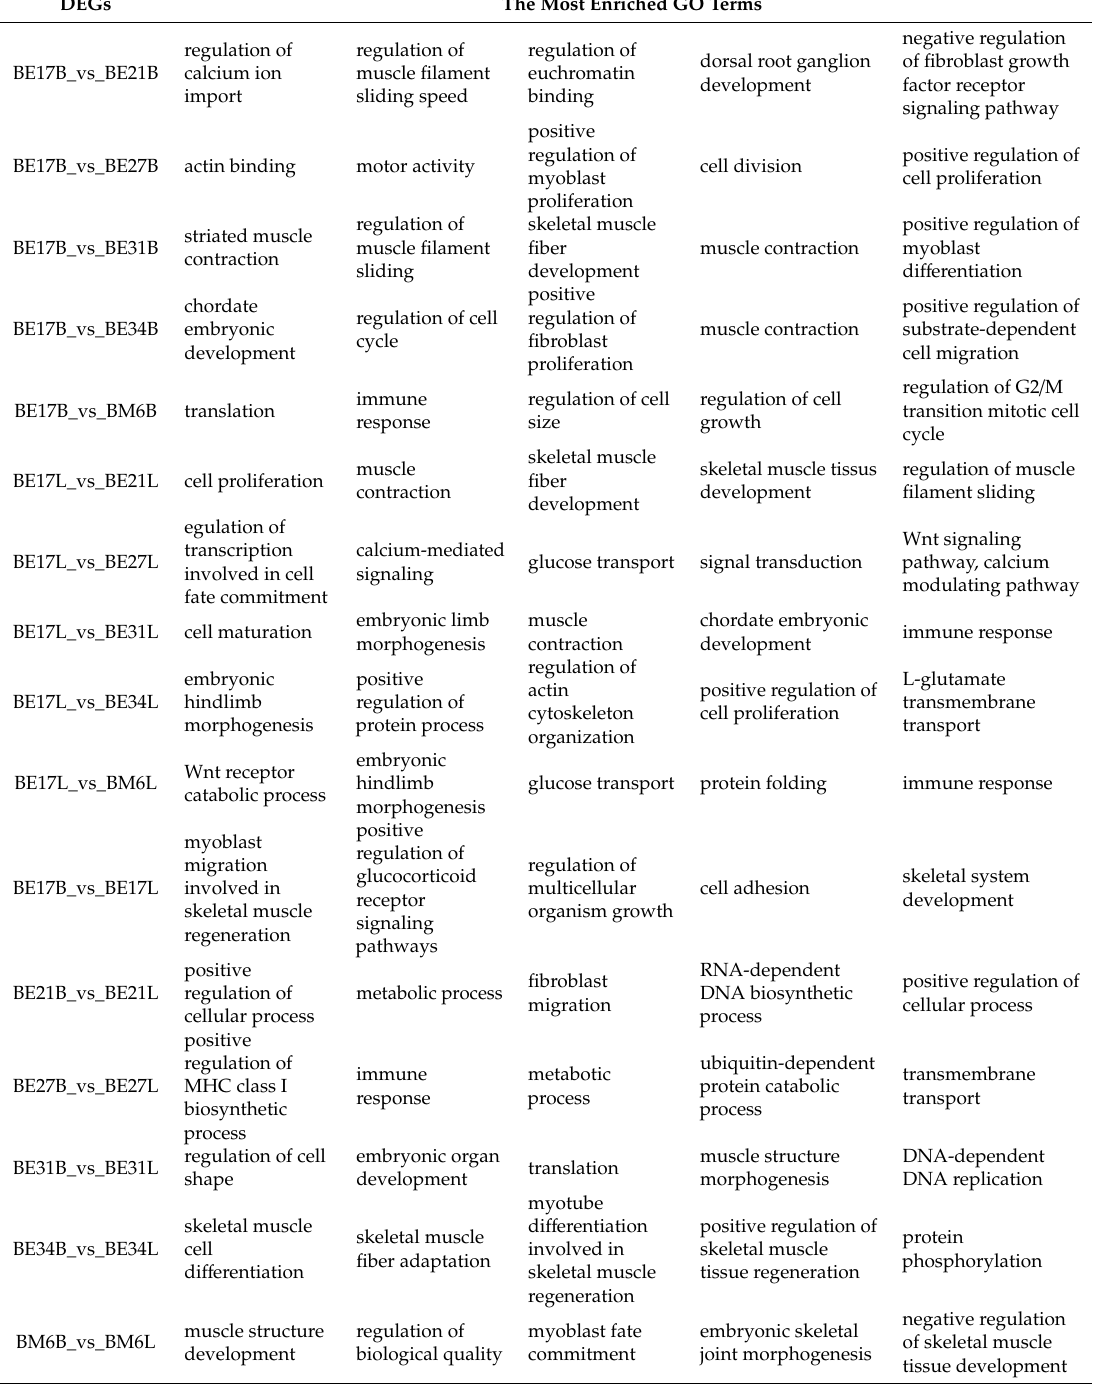
Table 6. The most enriched GO